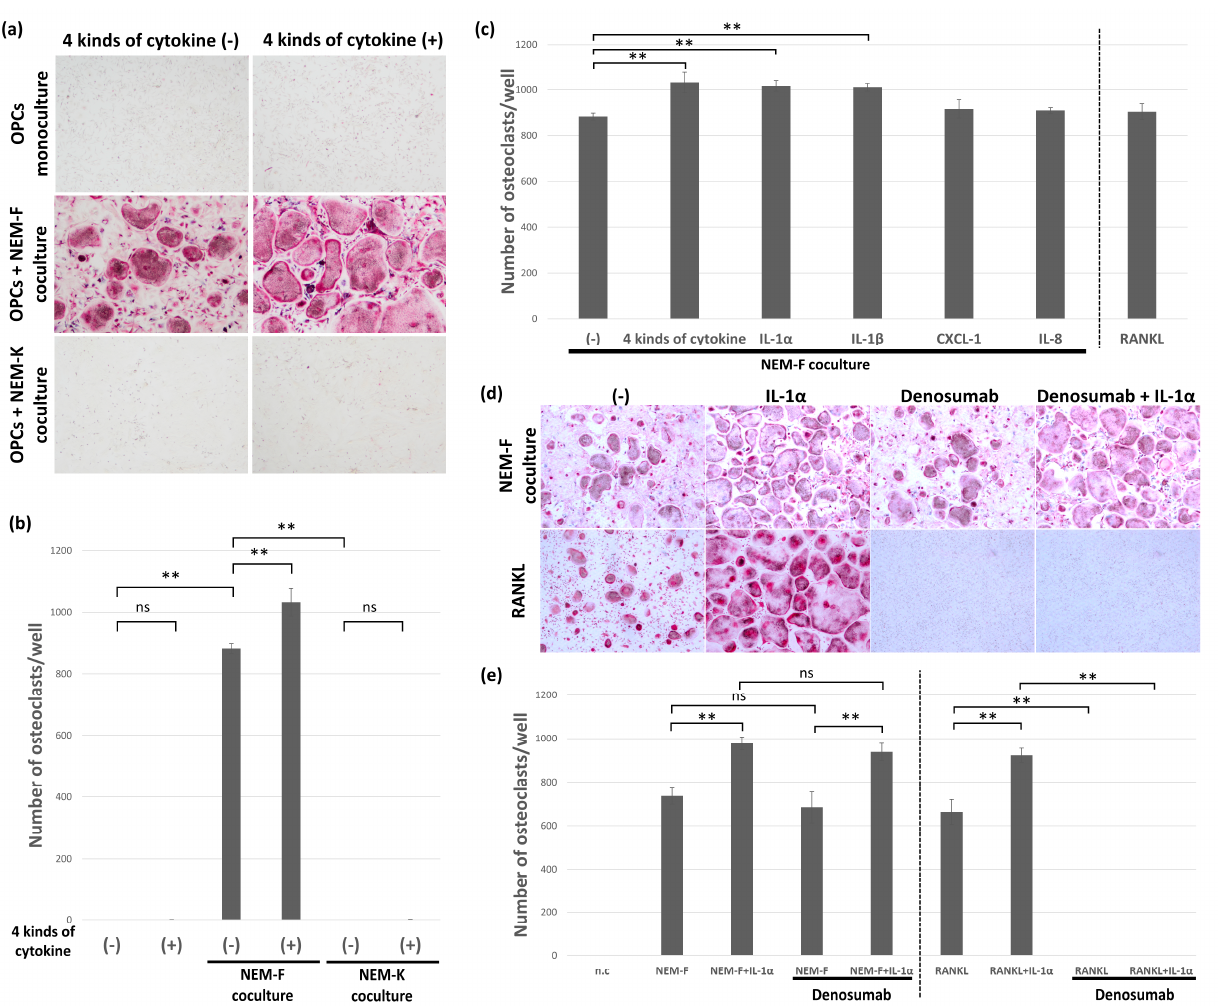
Figure 2. Characterization of selected inflammatory cytokines on stimulation or induction of osteoclastogenesis. ( a ) Representative views of TRAP staining 5 days after the coculture of NEM-F or NEM-K cells with OPCs with or without supplementation of a mixture of IL-1 α , IL-1 β , IL-8, and CXCL1 and 5 days after the culture of OPCs with or without supplementation of a mixture of IL-1 α , IL-1 β , IL-8, and CXCL1. ( b ) The number of osteoclasts 5 days after the coculture of NEM-F or NEM-K cells with OPCs with or without supplementation of a mixture of IL-1 α , IL-1 β , IL-8, and CXCL1 and 5 days after the culture of OPCs with or without supplementation of a mixture of IL-1 α , IL-1 β , IL-8, and CXCL1. ** p < 0.01, ns: not significant (one-way ANOVA with the Tukey–Kramer method). ( c ) Quantitative data on the number of osteoclasts 5 days after the coculture of NEM-F cells with OPCs supplemented with each inflammatory cytokine. ** p < 0.01 (one-way ANOVA with the Tukey–Kramer method). ( d ) Evaluation of the effects of denosumab on osteoclastogenesis induced